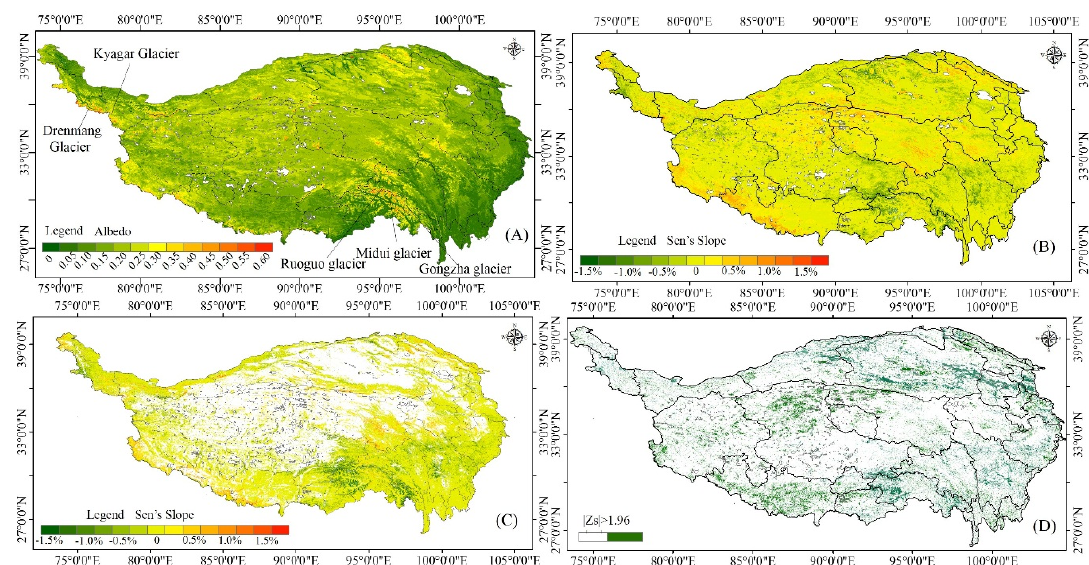
Figure 3. Evolution of the land surface albedo from 2001 to 2019: ( A ) the annual albedo; ( B ) the albedo variation showed by the Sen’s slope over the entire TP, ( C ) the significant land surface albedo variation displayed by the Sen’s slope, and ( D ) the Z test results.